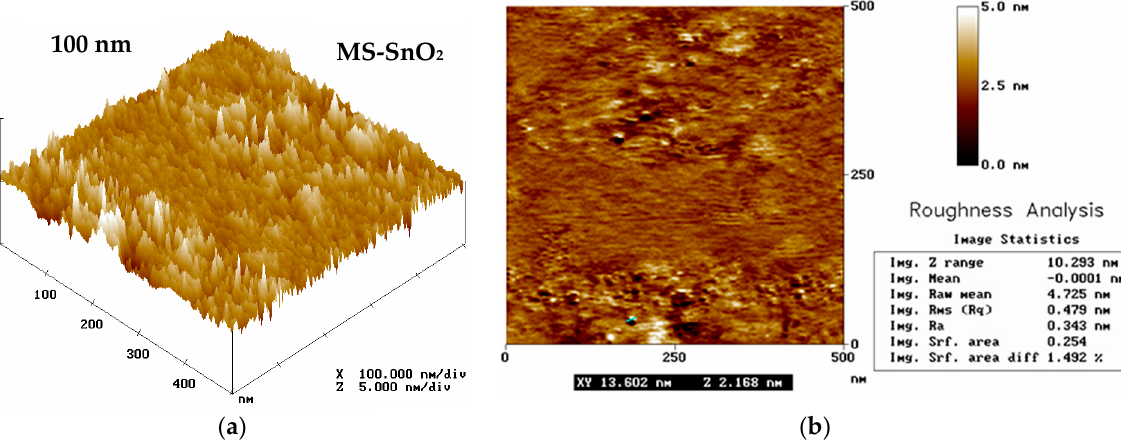
Figure 4. AFM images (500 nm × 500 nm) of the MS-SnO 2 film of thickness d = 100 nm formed using the magnetron sputtering method with measurements of crystallites and film topography: ( a ) 3D image and ( b ) 2D image.